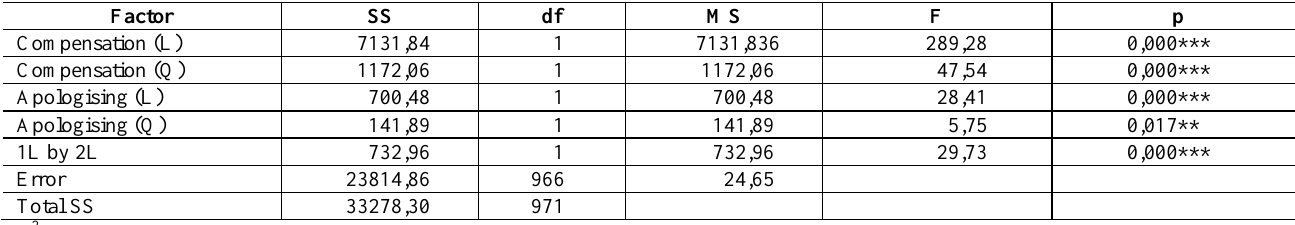
Table 7: ANOVA results: Study 1, dry cleaning Factor SS